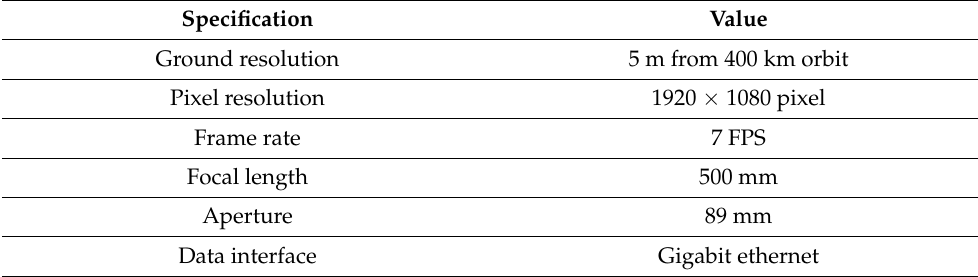
Table 1. HiREV payload specification.